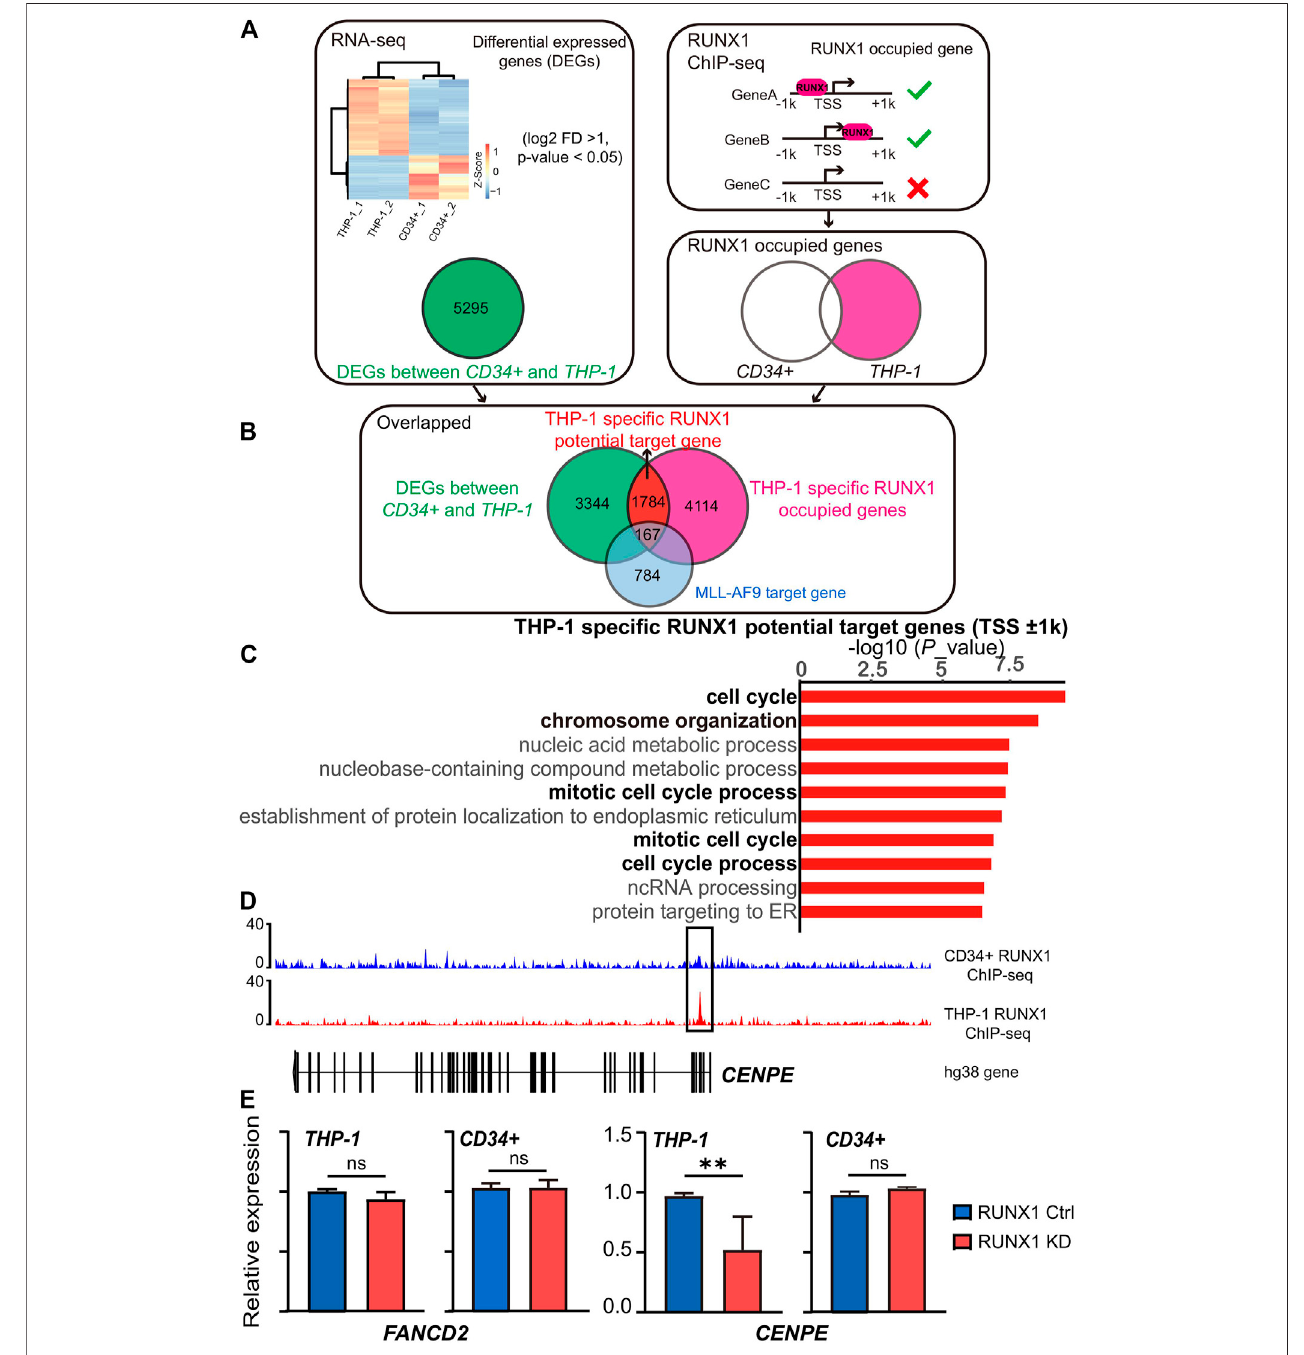
FIGURE 1 | RUNX1 in leukemia cells regulates cell cycle-associated biological process. (A) Work fl ow for choosing differential expression genes and the RUNX1 occupiedgenes.HeatmapshowedtheRNA-seqdifferentiallyexpressedgenes(DEGs)(FDR p < 0.1and > 2-foldchange)betweenTHP-1cellsandCD34 + cells.RUNX1 occupiedgeneswasde fi nedasgenescontainedRUNX1bindingaround ± 1 kbrelativetoTSS. (B) Work fl owforchoosingTHP-1speci fi cRUNX1potentialtargetgenes. For THP-1 speci fi c RUNX1 potential target genes, we overlapped DEGs with THP-1 speci fi c RUNX1 occupied genes. (C) Gene Ontology (GO) analysis of 1784 differentially expressed genes that contain RUNX1 binding site but without MLL-AF9 occupied in promoter regions ( ± 1 kb relative to TSS) for THP-1 cells. Black font indicatesthebiologicalpathwaysthatarerelatedtocellgrowth;grayfontindicatesotherbiologicalpathways. (D) RUNX1peakslocatedintheproximalvicinityofTSSsof CENPE. (E) qPCR con fi rmed FANCD2 and CENPE mRNA expression of THP-1 cells and CD34 + cells with or without RUNX1 shRNA. (one-way ANOVA, * p < 0.05, ** p < 0.01,*** p < 0.001; error bars, median ± SD).